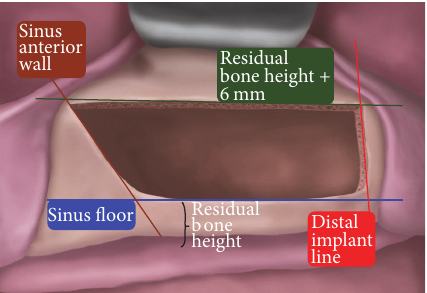
Figure 1: The Low Window Sinus Lift antrostomy. The lower osteotomy line (blue) is positioned flush with the sinus floor. The upper one (green) is 6 mm higher; that is, it is placed at a distance from the ridge equal to the residual bone height plus 6 mm. The mesial line (brown) is flush to the sinus anterior wall. The distal one (red) should be placed in correspondence with the position of the most distal implant.